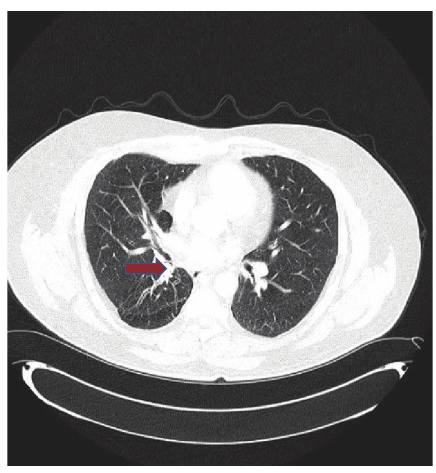
Figure 1: CT scan showing endobronchial mass (red arrow).